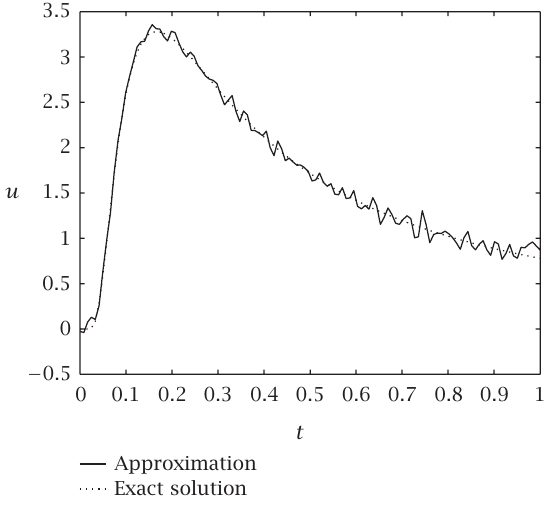
Figure 3.1. x = 0, p = 2 / 3, δ = 10 − 4 , E = 6, k = 1 / 122.